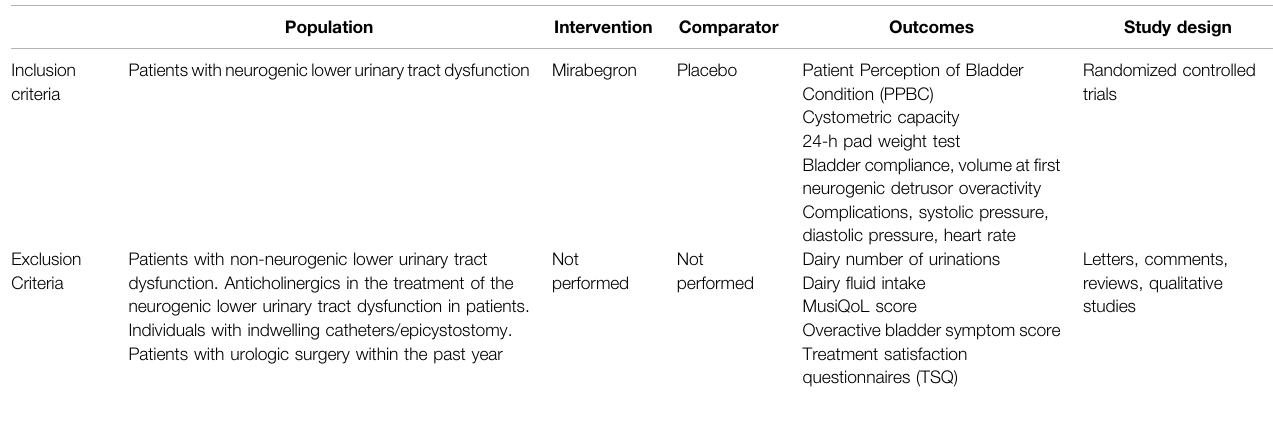
TABLE 1 | Search strategy according to populations, interventions, comparators, outcomes, and study designs (PICOS).